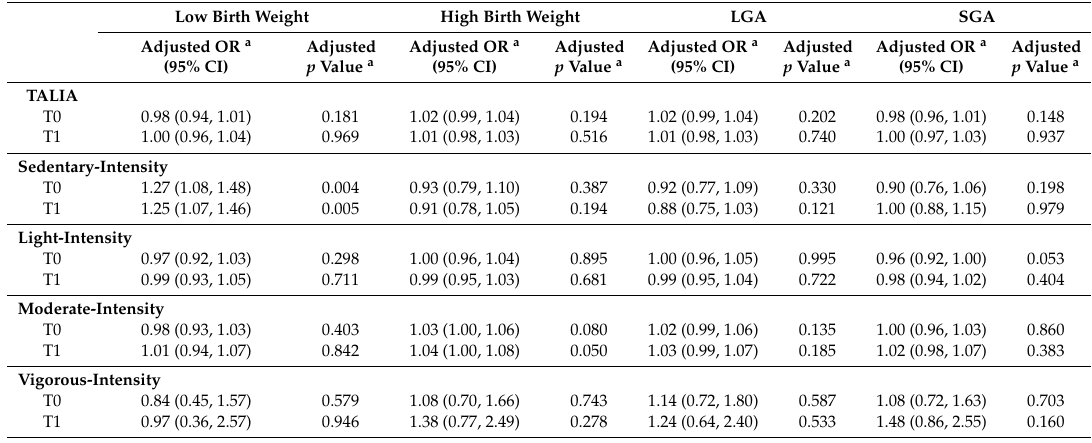
Table 4. Associations between physical activity intensity and neonatal